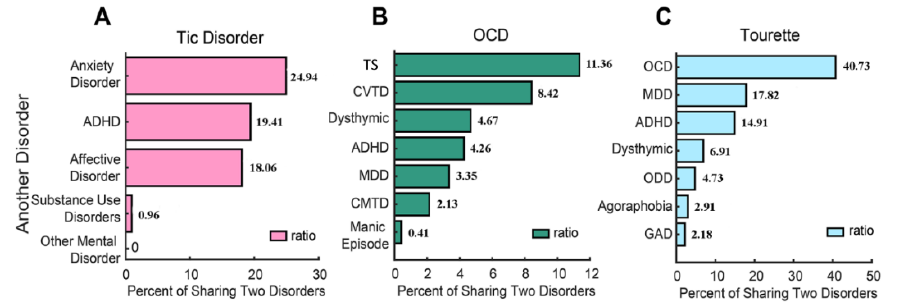
Figure 4. The comorbidities of TD ( A ), TS ( C ), and OCD (%) ( B ) (ADHD: attention-deficit/hyperactivity disorder; OCD: obsessive-compulsive disorder; TS: Tourette’s syndrome; CVTD: chronic vocal tic disorder; MDD: major depressive disorder; CMTD: chronic motor tic disorder; ODD: oppositional defiant disorder; GAD: generalized anxiety disorder).